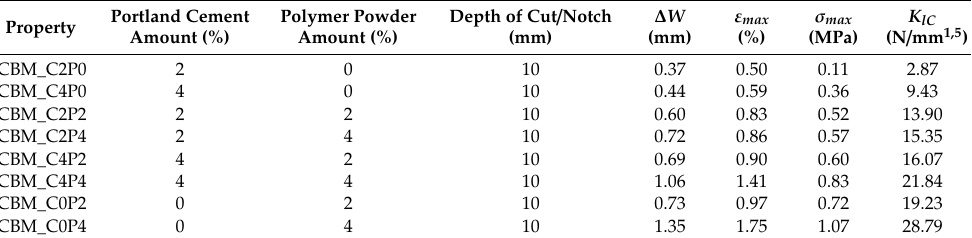
Table 13. Average values of the results of fracture toughness determination.